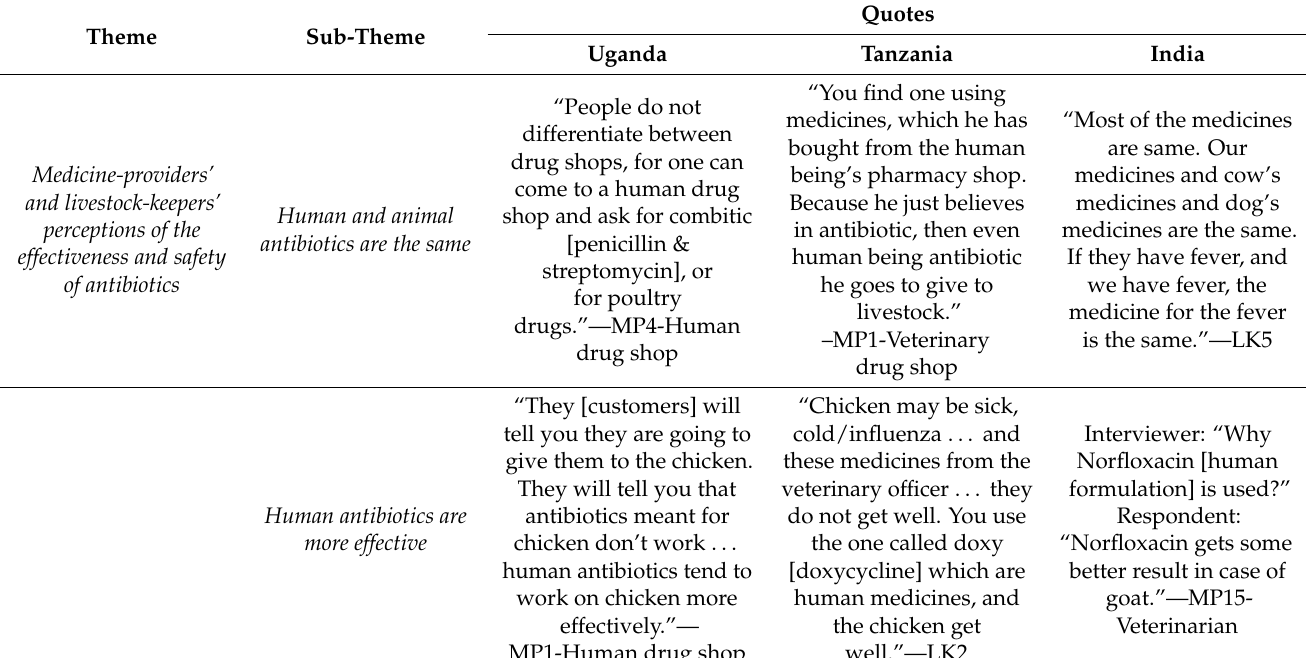
Table 2. Additional illustrative quotes for common themes by